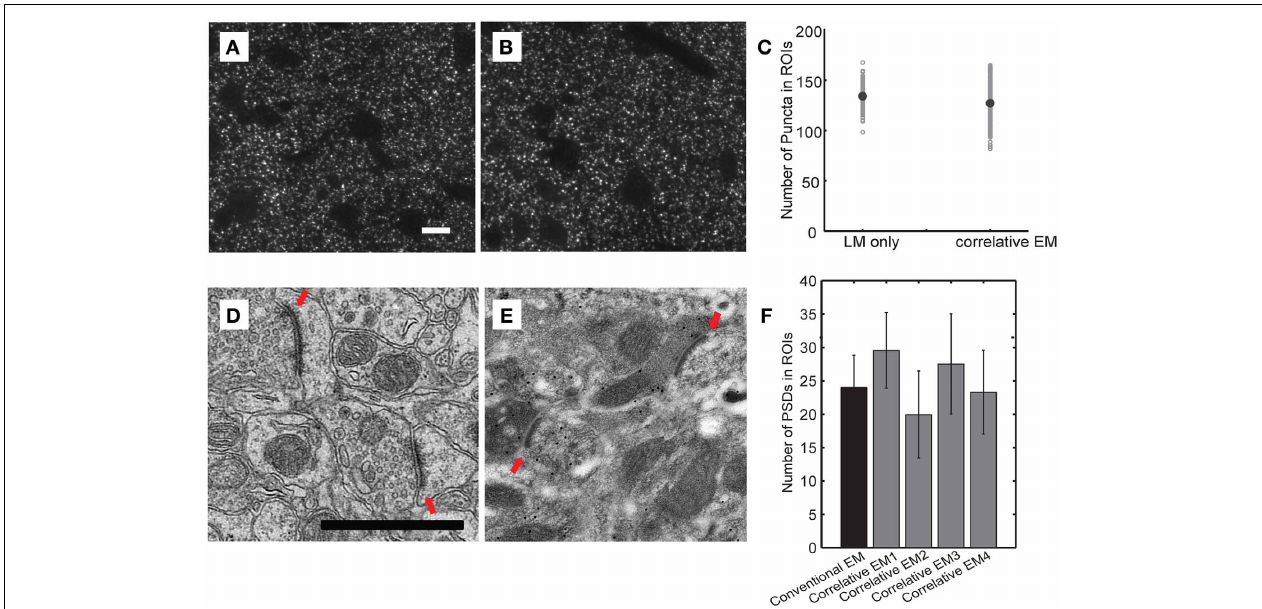
FIGURE 5 | Preparation conditions used for correlative electron microscopy preserve antigenicity while allowing reliable EM detection of synapses. (A–C) Comparison of number of synaptophysin-positive punctae using different fixation protocols. Representative light microscopic images of synaptophysin immunostaining in sections from brains fixed using the LSAT protocol (A) and the correlative EM protocol (B) . Quantification of synaptophysin-positive punctae in the two conditions (C) .